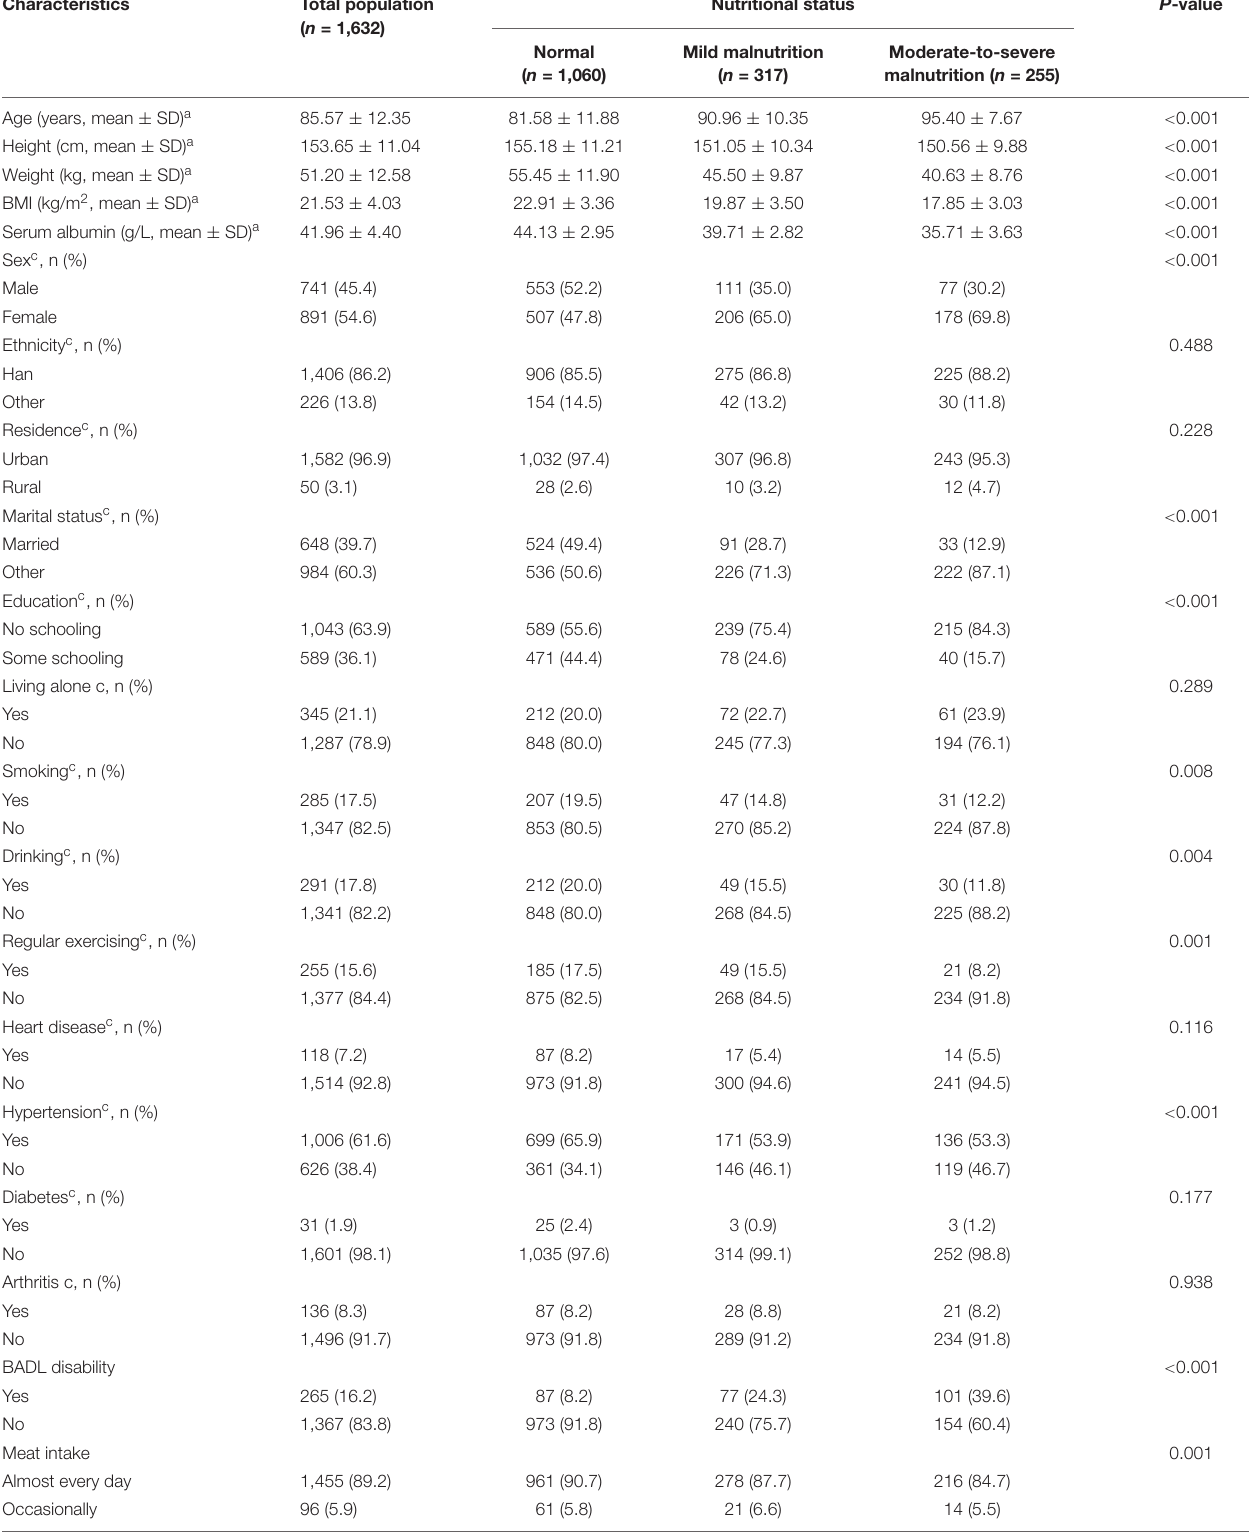
TABLE 1 | Characteristics of